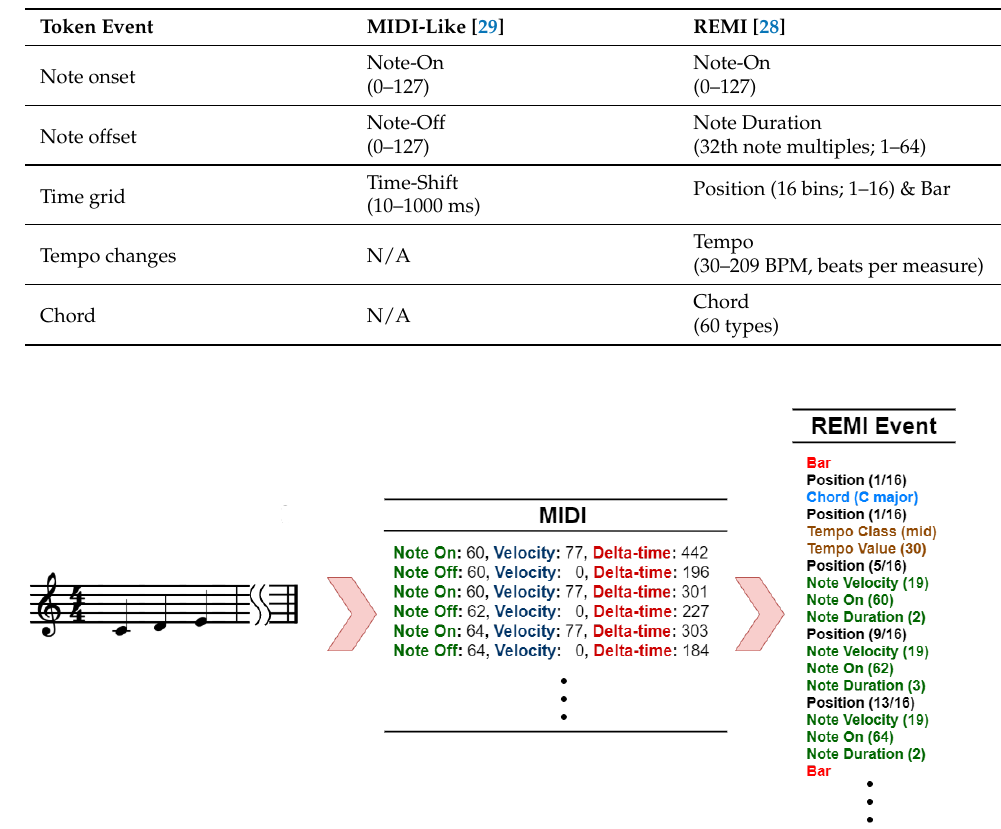
Figure 8. An example of REMI